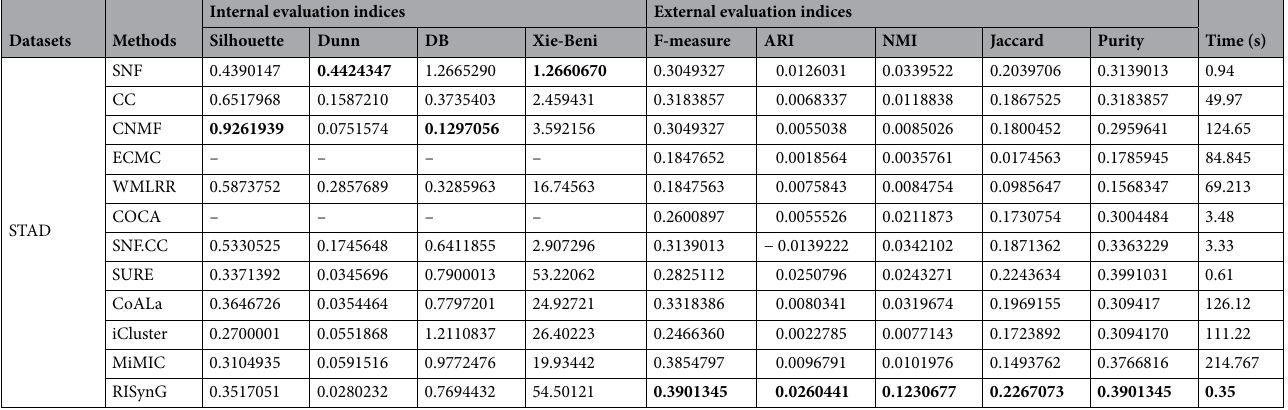
Table 3. Comparative cluster analysis of proposed and existing approaches. The bold values indicate the best score as reported in the text.